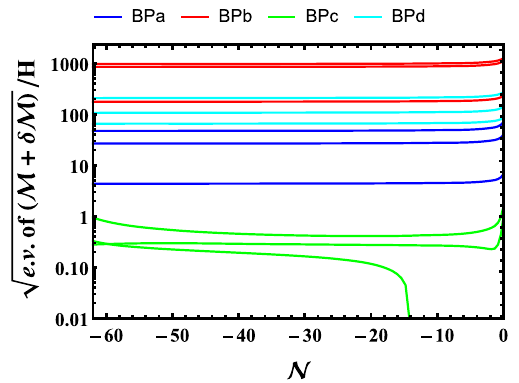
+ δ M I in Eq. (30) J J